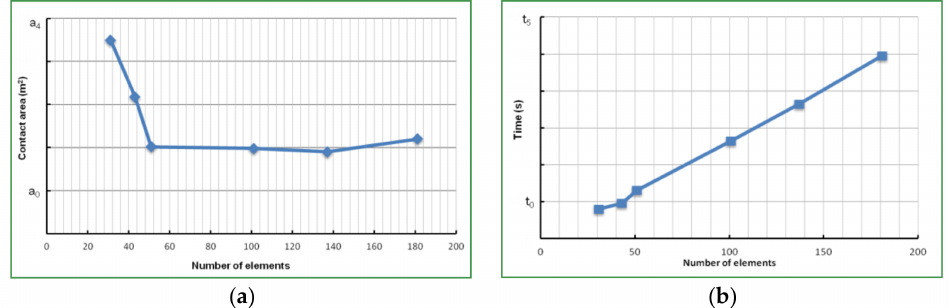
Figure 16. ( a ) Variation of contact area as a function of the number of elements, ( b ) computational time (CPU) as a function of the number of elements.